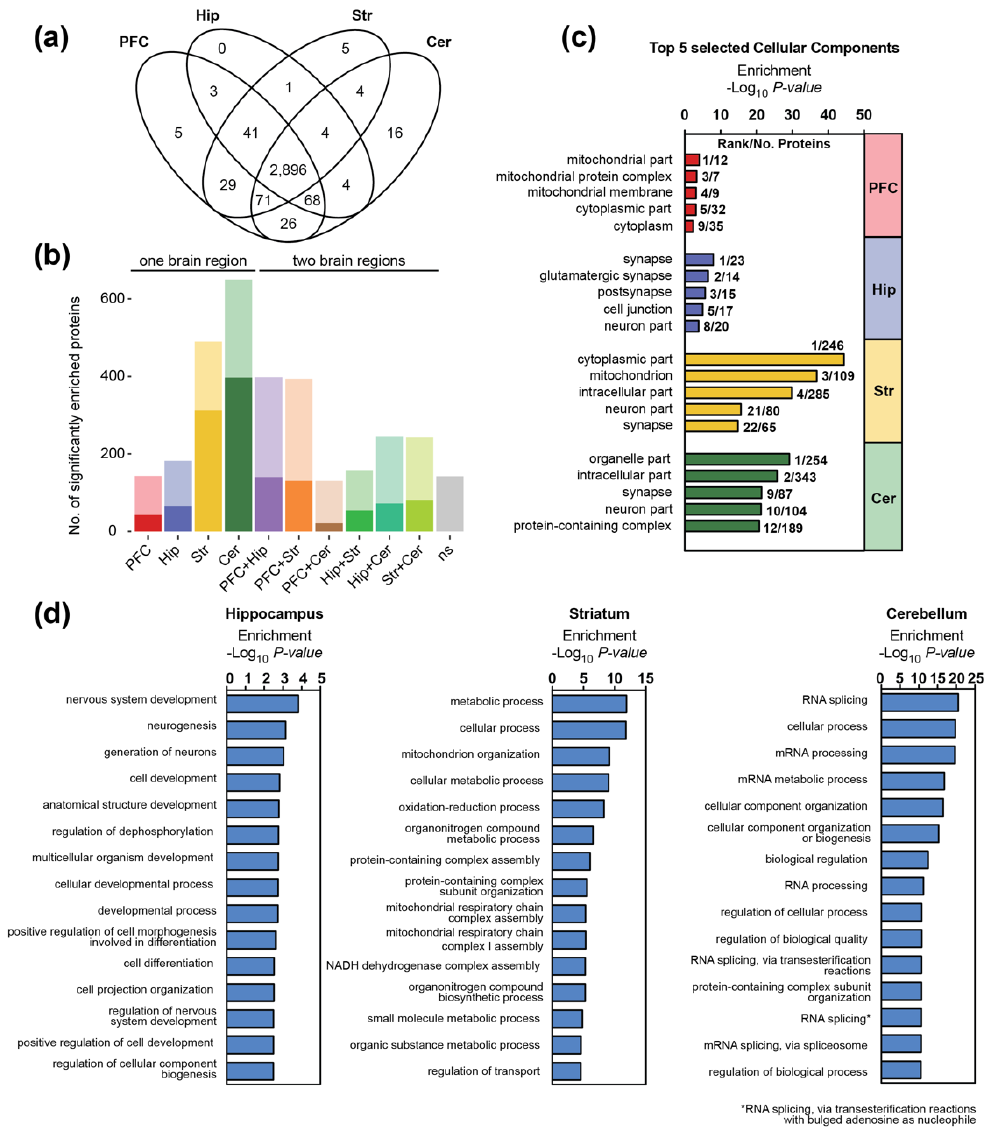
Figure 2. Composition of the synaptic proteome differs between brain regions: ( a ) Overlap of proteins identified at the synapses of the prefrontal cortex (PFC), hippocampus (Hip), striatum (Str) and cerebellum (Cer). Presence of the proteins was inferred following alignment between runs. ( b ) Number of significantly enriched proteins in one or two brain regions (BH corrected Student´s t-test, p < 0.05). Proteins were always assigned to the group displaying the highest significance (i.e., lowest p-value). Transparent bars display numbers of all significant proteins and non-transparent bars proteins that are at least 2-fold enriched; ( c , d ) Gene Ontology (GO) enrichment analysis of synaptic proteins that are significantly associated with a certain brain region (Benjamini–Hochberg correction, p < 0.05, log 2 fold change compared to other regions >1). ( c ) Selected GO terms for components as well as the ( d ) top 15 biological processes are displayed. In case of PFC-specific synaptic proteins, no biological process was significantly enriched.